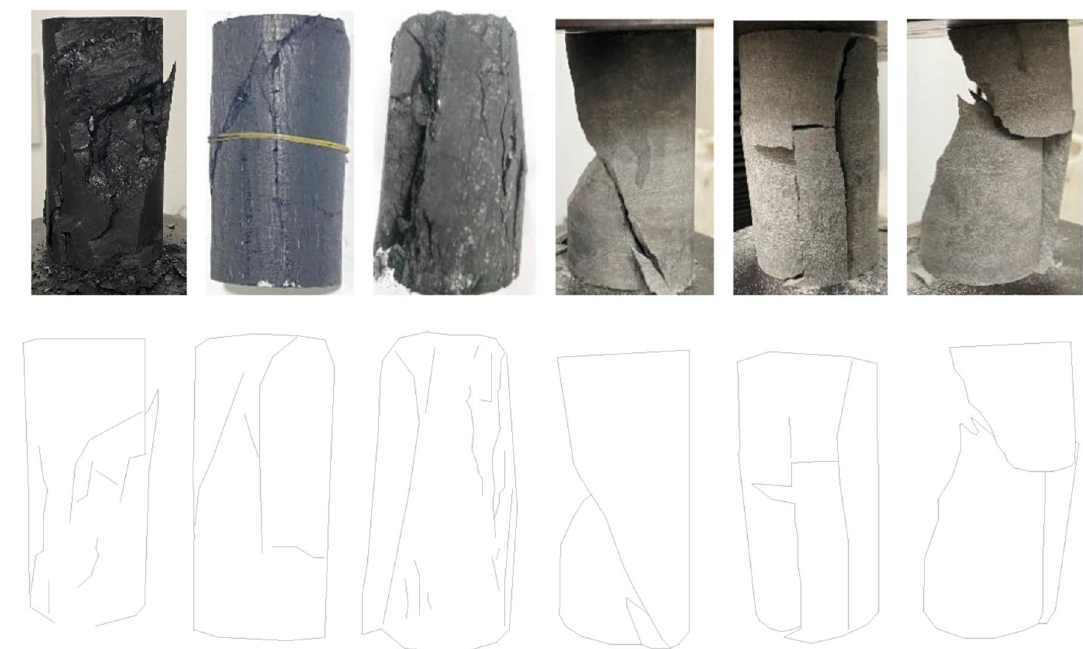
Fig. 8 Failure morphological characteristics of raw coal and